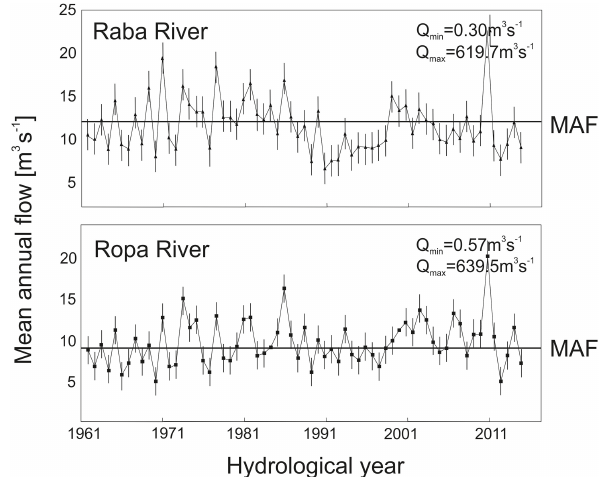
Figure 3. Changes in hydrological regime of the Raba and Ropa rivers. The horizontal line indicates the mean annual flow